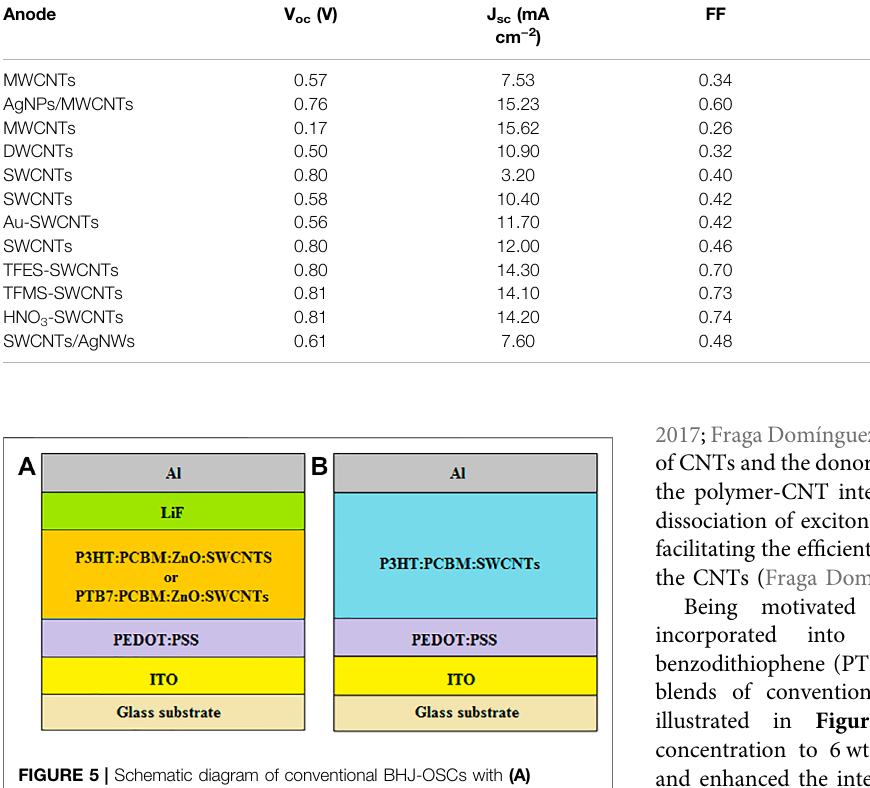
TABLE 1 | Photovoltaic parameters of OSCs employing CNT-based anodes. Anode